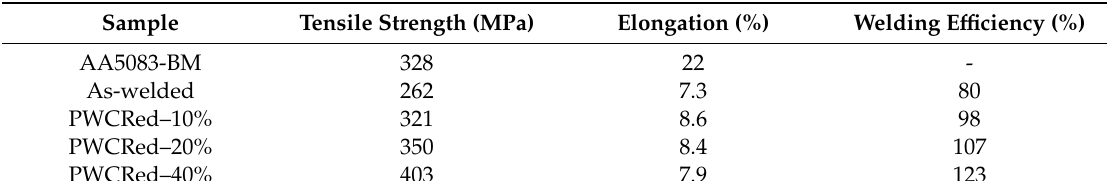
Table 2. Tensile properties of AA5083-BM, as-welded, and post-weld cold-rolling (PWCR)ed samples.